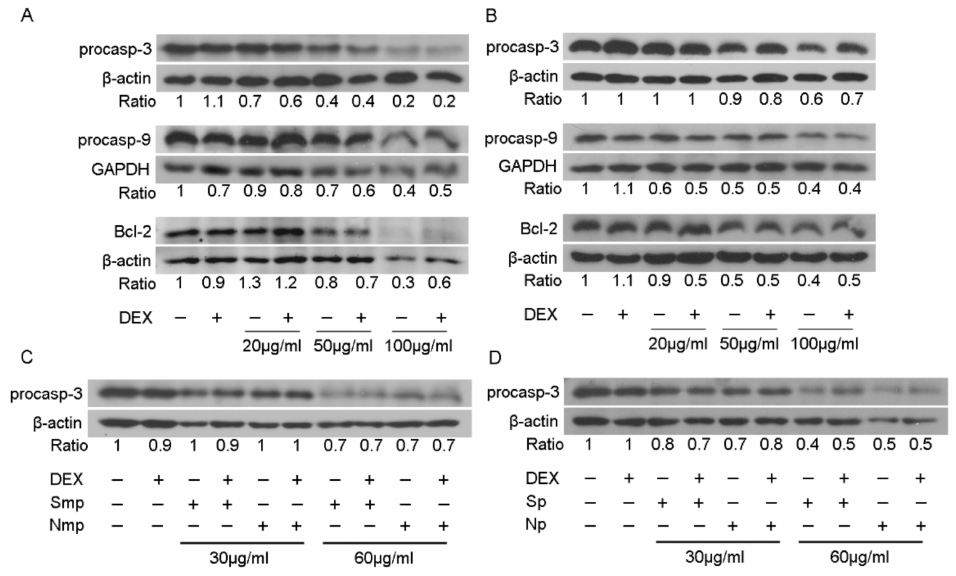
Figure 8. Induction of apoptosis by medium-polar ( A , C ) and polar ( B , D ) leaves fractions of South ( A , B ) and South versus North ( C , D ) Chios mastiha tree. Western blot analysis of β -actin, GAPDH, procaspase-3, procaspase-9 and Bcl-2 protein levels in cell extracts from HEK293 cells treated with 20 to 100 µ g/mL of leaves fractions and/or 10 nM DEX, for 48 ( C , D ) and 72 h ( A , B ) in hormone-depleted medium was performed using commercially provided antibodies. β -actin or GAPDH protein levels were assessed for the normalization of the